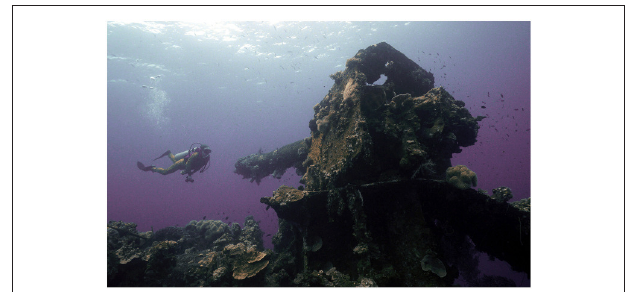
FIGURE 2 | Bow gun and support base on the Fujikawa Maru with a corrosion rate of